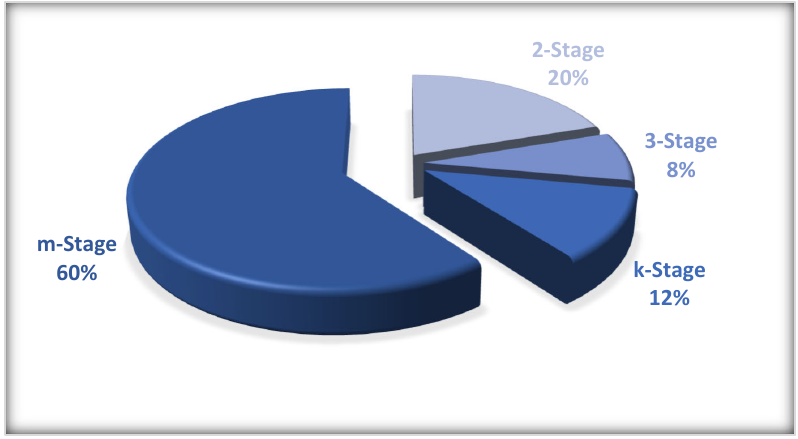
Fig. 7. Percentage distribution of HFS articles according to number of stages